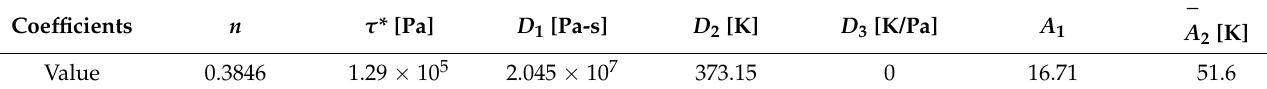
Table 1. Cross-WLF viscosity model coefficients for PLA 3251D, in Equation (3).